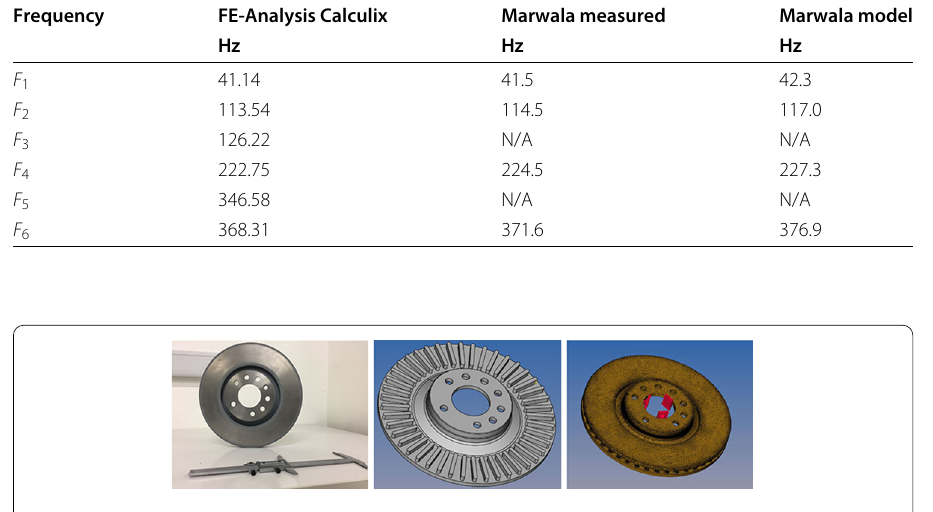
Fig. 8 Sample brake disk photo, geometry (Cut) and meshing of sample brake